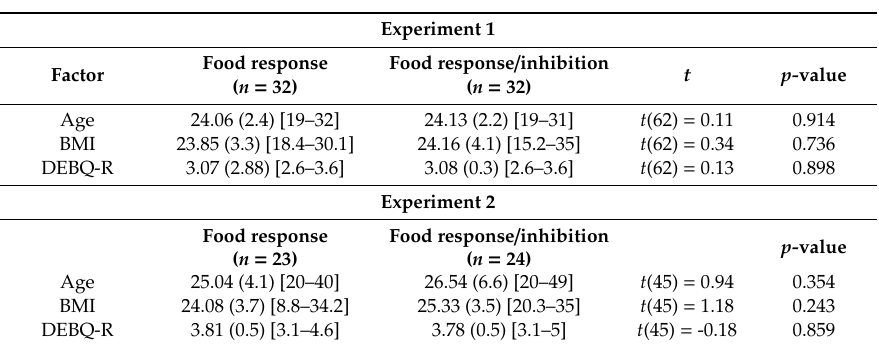
Table 1. Characteristics of training and control